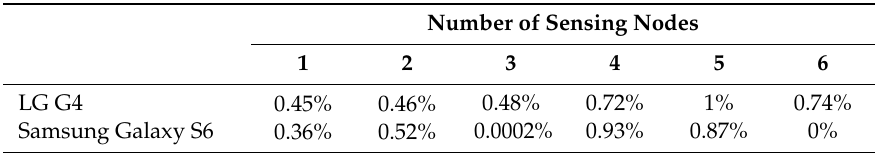
Figure 3. Performance metrics as a function of the number of connected sensors for a sampling rate of 50 Hz: ( a ) Battery duration; ( b ) relative battery lifetime (lifespan per consumed mAh); ( c ) number of messages received per consumed mAh; ( d ) number of lost messages per consumed mAh. Table 3. Percentage of lost measurements for the LG G4 and Samsung Galaxy S6 using a sampling rate of 50 Hz as a function of the number of sensing